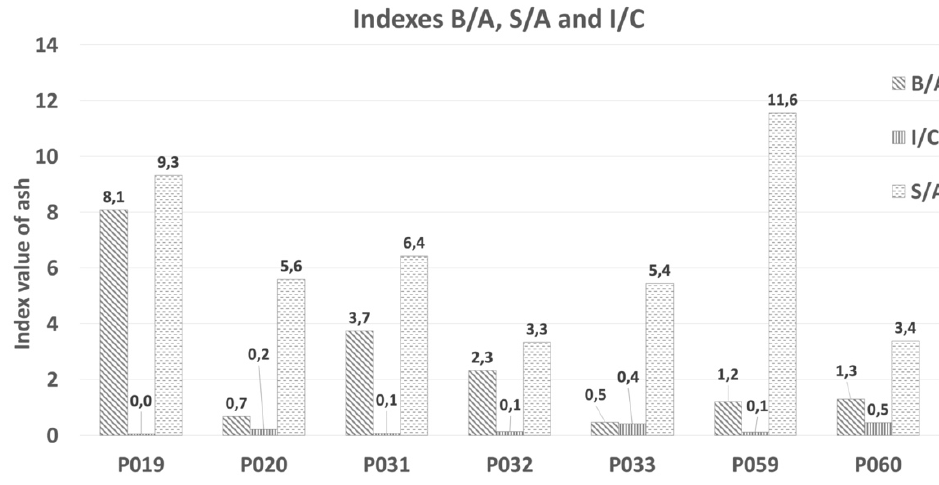
Figure 7. Indices B/A, S/A, and I/C for individual ash samples. The I/C value for the tested samples was >0.3 and represents a small risk for the deg- radation of refractory materials. S/A index values were higher for all tested ash samples. the slagging tendency based on the silica/alumina ratio (S/A) was high for all the ash samples because no value was lower than 3 (Figure 7).